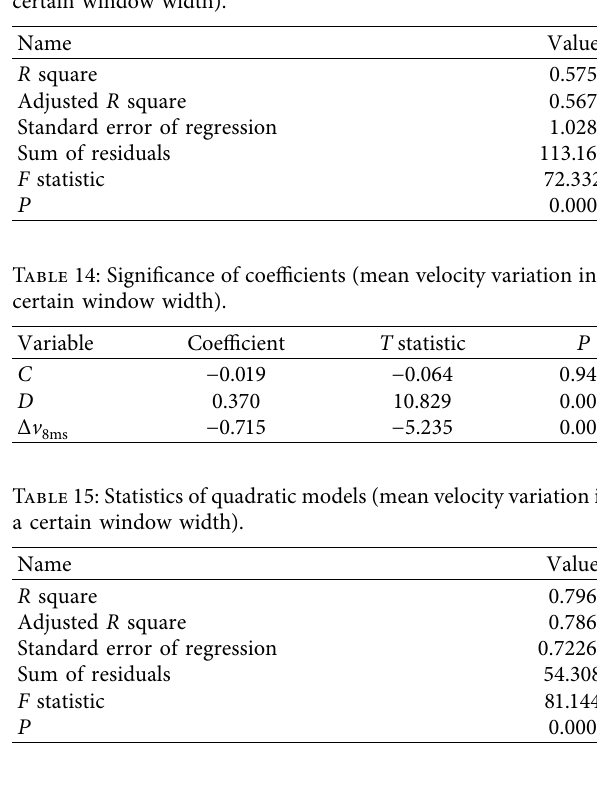
Figure 15: Velocity variation error-mean velocity variation in a window width of 8 ms-discrimination threshold regression equation 3D